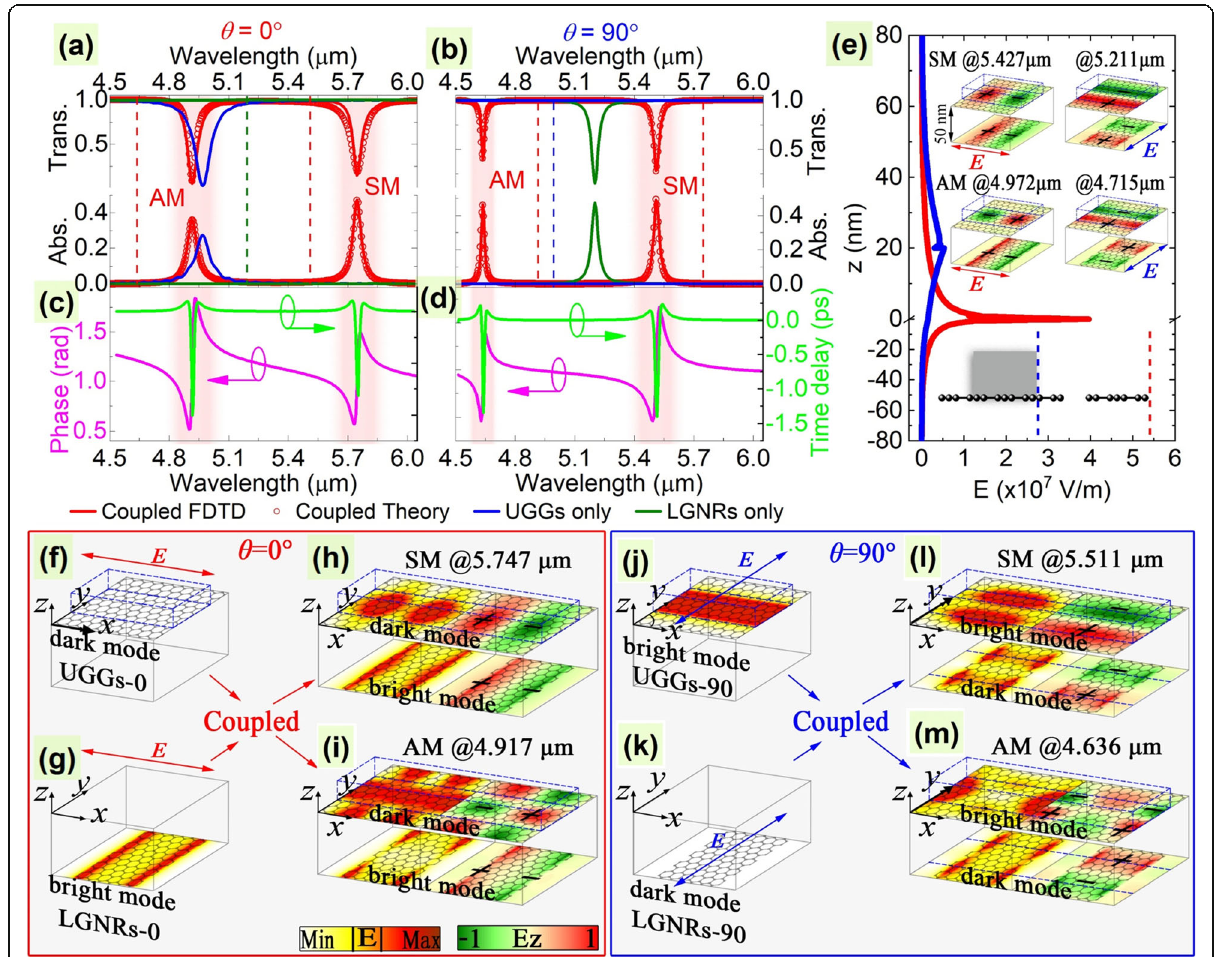
Fig. 2 Transmission and absorption lines ( a , b ) and their transmission phase (left y axis) and delay time (right y axis) ( c , d ) of the system with polarization angle θ = 0° ( a , c ) and 90° ( b , d ), respectively. In ( a ) and ( b ), the dashed lines show the resonant position at the other polarization. The fitting parameters of the theoretically analyzed lines in ( a ) and ( b ) are (in THz) 6.71, 110.07, 2.25, 0.46, and 0.74, and 5.73, 4.13, 72.83, 0.33, and 0.27 for κ i , Q 1i /sqrt( ε 0 m 1i ), Q 2i /sqrt( ε 0 m 2i ), γ 1i , and γ 2i , respectively. Spatial distributions of the electric field for the cases with UGGs ( e (blue line), f , j ) and LGNRs ( e (red line), g , k) only along the z axis ( e ) and in the corresponding graphene planes ( f , g , j , k ). Spatial distributions of the electric field (left panels) and the corresponding z component (right panels) of the symmetric mode (SM) ( h , @5.747 μ m; l , @5.511 μ m) and antisymmetric mode (AM) ( i , @4.917 μ m; m , @4.636 μ m) at polarization angles θ = 0° ( h , i ) and 90° ( l , m ), respectively. The upper inserts in e show z component of the electric field for the case with d = 50 nm, while the lower insert depicts the position of the field in the main plot. Signs “ + ” and “ − ” donate the resonating surface charges; the darker color refers to a larger charge density corresponding absorption peaks. It is these two fun- Fig. 2l and m, the E component field distributions z damental modes that eliminate the resonant absorp- show a dipole mode resonance featured by a 2 π phase tion of the case with only the UGGs while generating shift along the y axis in each graphene layer and re- a prominent transmission window and two absorption veal in-phase (symmetric mode) and out-of-phase peaks in the optical spectrum, resulting in another (antisymmetric mode) resonances at the Table 1 Characteristic parameters of Fig. 2a and b Modes Wavelength ( μ m) Absorption ratio (%) Line width (nm) θ = 0° Symmetric mode θ = 90° Symmetric